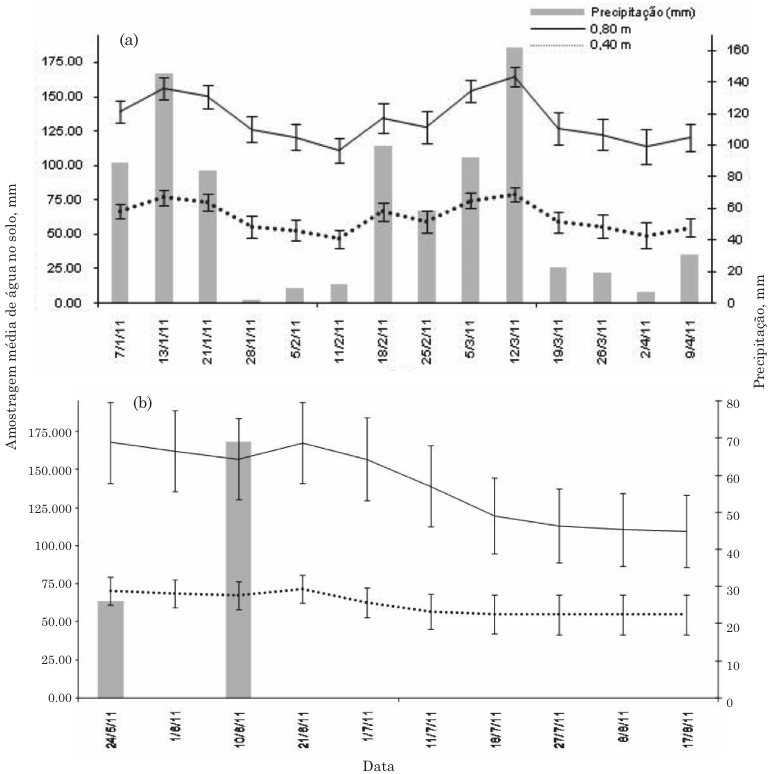
Figura 2. Média geral da armazenagem de água no solo para as camadas de 0-0,40 e 0-0,80 m, precipitação pluvial (mm) e respectivos desvios-padrão durante o ciclo de desenvolvimento de feijoeiro (a) e aveia- preta